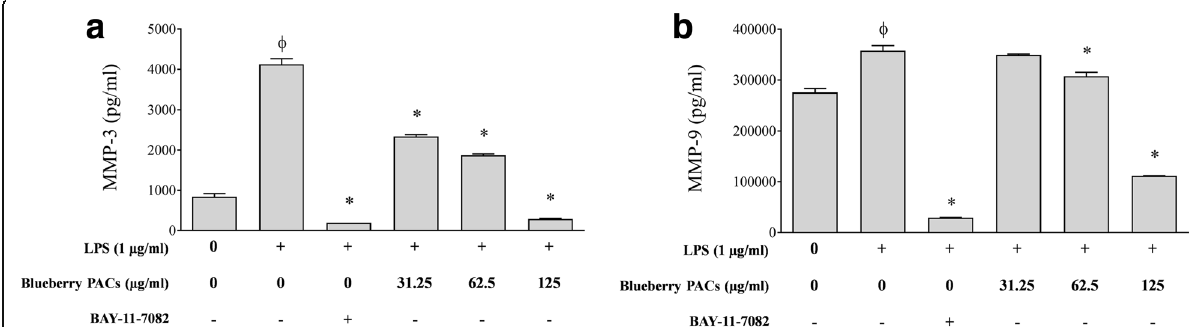
Fig. 7 Effect of highbush blueberry PACs on the secretion of a MMP-3 and b MMP-9 by macrophages stimulated with A. actinomycetemcomitans LPS . The commercial inhibitor BAY-11-7082 (25 μ M) was used as a positive inhibitory control. Results are expressed as the means ± SD of triplicate assays from three independent experiments. Φ : significant increase ( p <0.001) compared to unstimulated control cells. *: significant decrease ( p <0.001) compared to LPS-